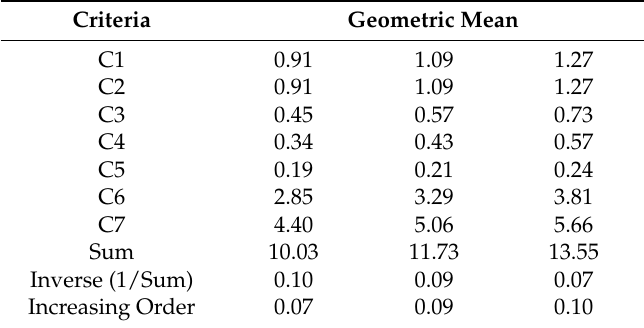
Table 8. Geometric means of fuzzy numbers (Expert